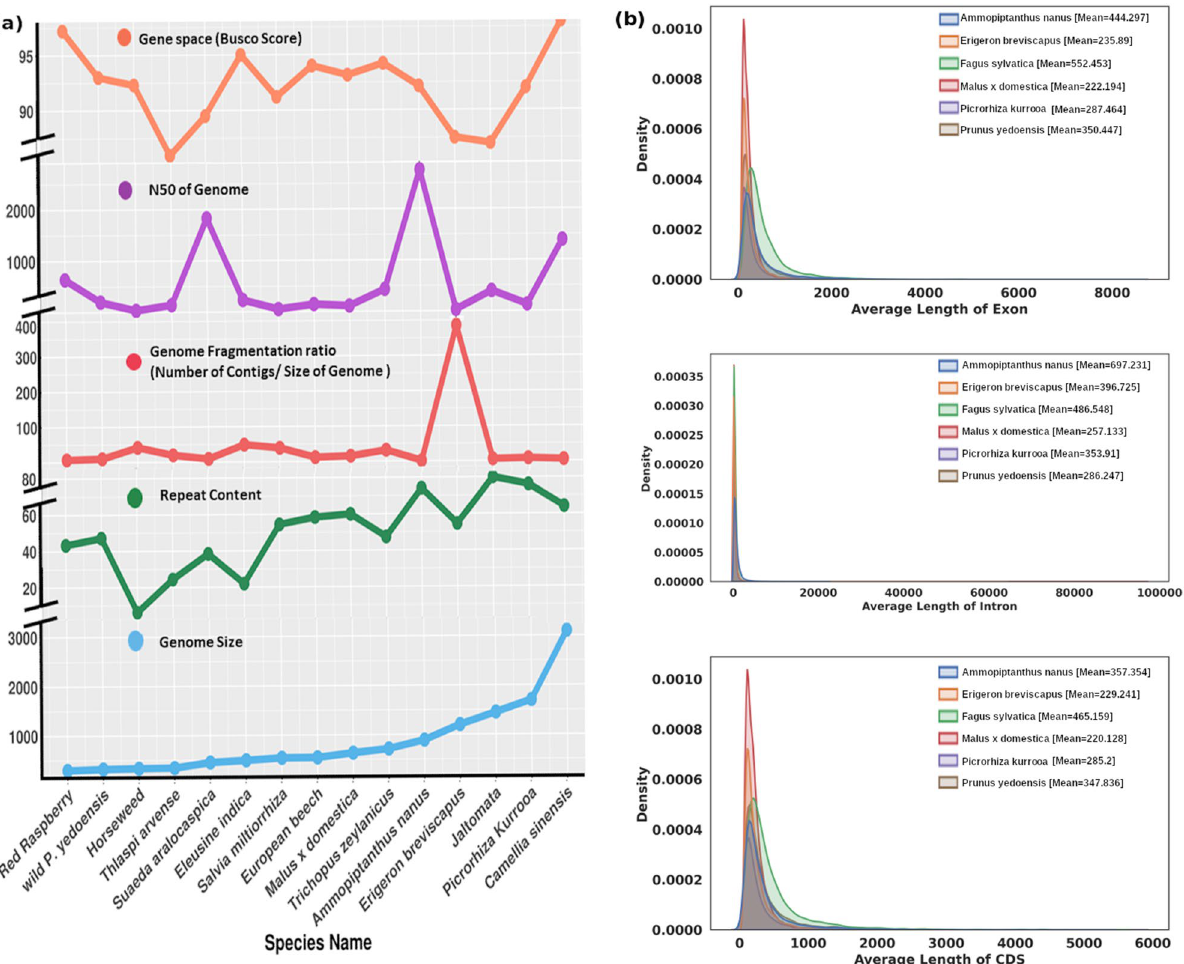
Figure 2. ( a ) Comparative plot of species depicting the genome size relationship with repeat content. With increasing size of genome, assembly fragmentation ratio also increases. N50 of P. kurrooa genome was higher than the previously reported assemblies and overall BUSCO score was 92.3% for the conserved genes. ( b ) Comparative plot of length distribution of exon, intron and coding sequence (CDS) regions of six different species along with P. kurrooa